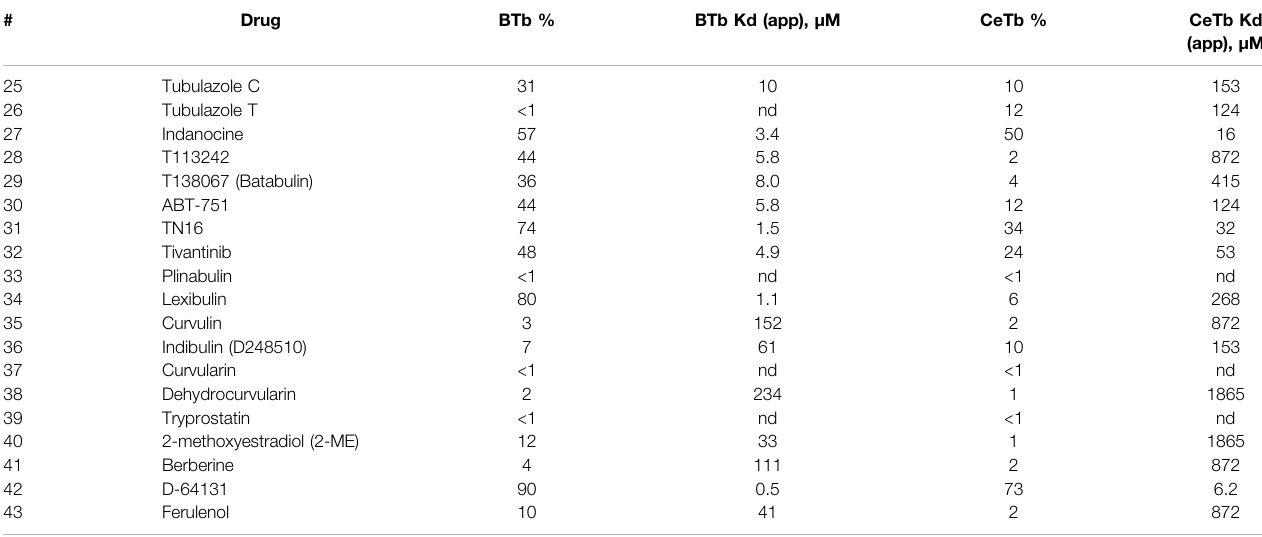
TABLE 7 | MDL competitive binding inhibition by other non-colchicine structure